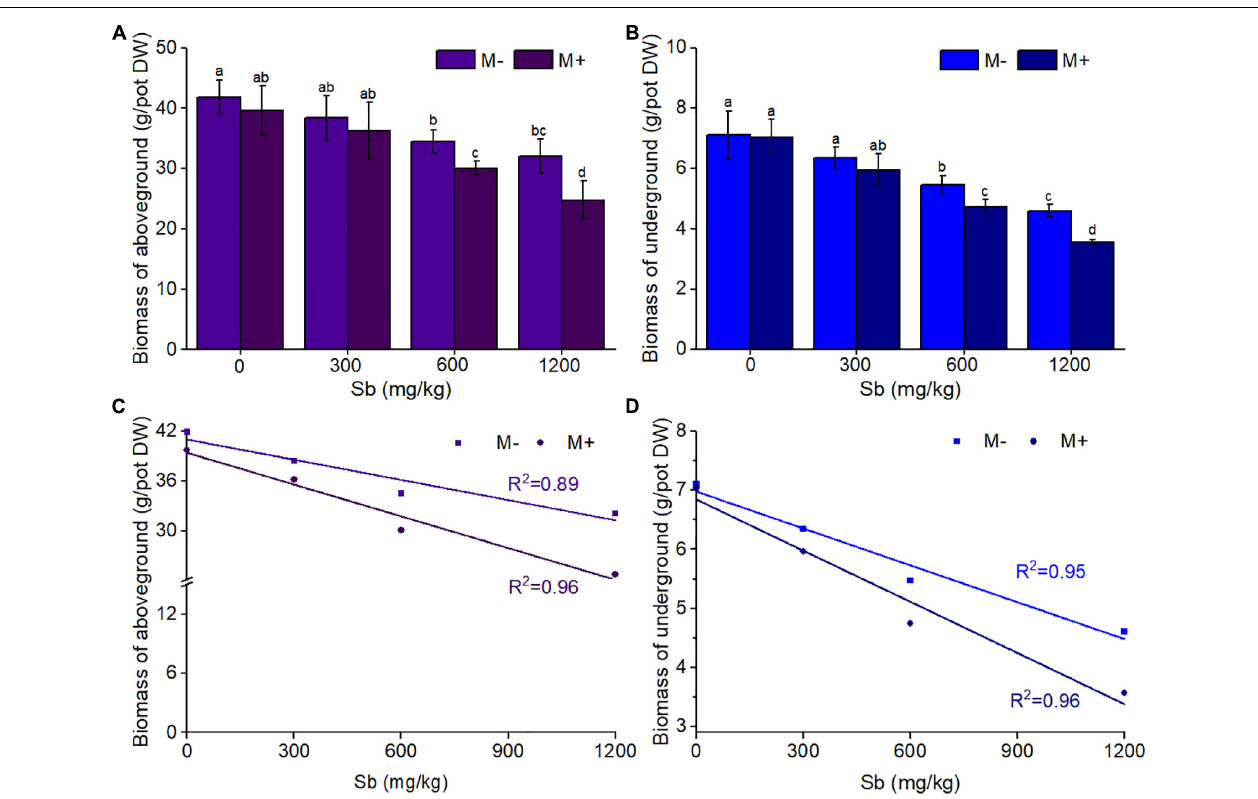
FIGURE 1 | Effects of AMF on rice biomass of aboveground and underground. (A) Biomass of aboveground, (B) biomass of underground, (C) the liner relationship between biomass of aboveground and concentrations of Sb, (D) the liner relationship between biomass of underground and concentrations of Sb. DW represents dry weight. Error bar was calculated from three parallel samples. Error bars sharing no common letter indicate that biomass are significantly different at P < 0.05 level for treatments. The data are means ± standard deviations (SDs) ( n =